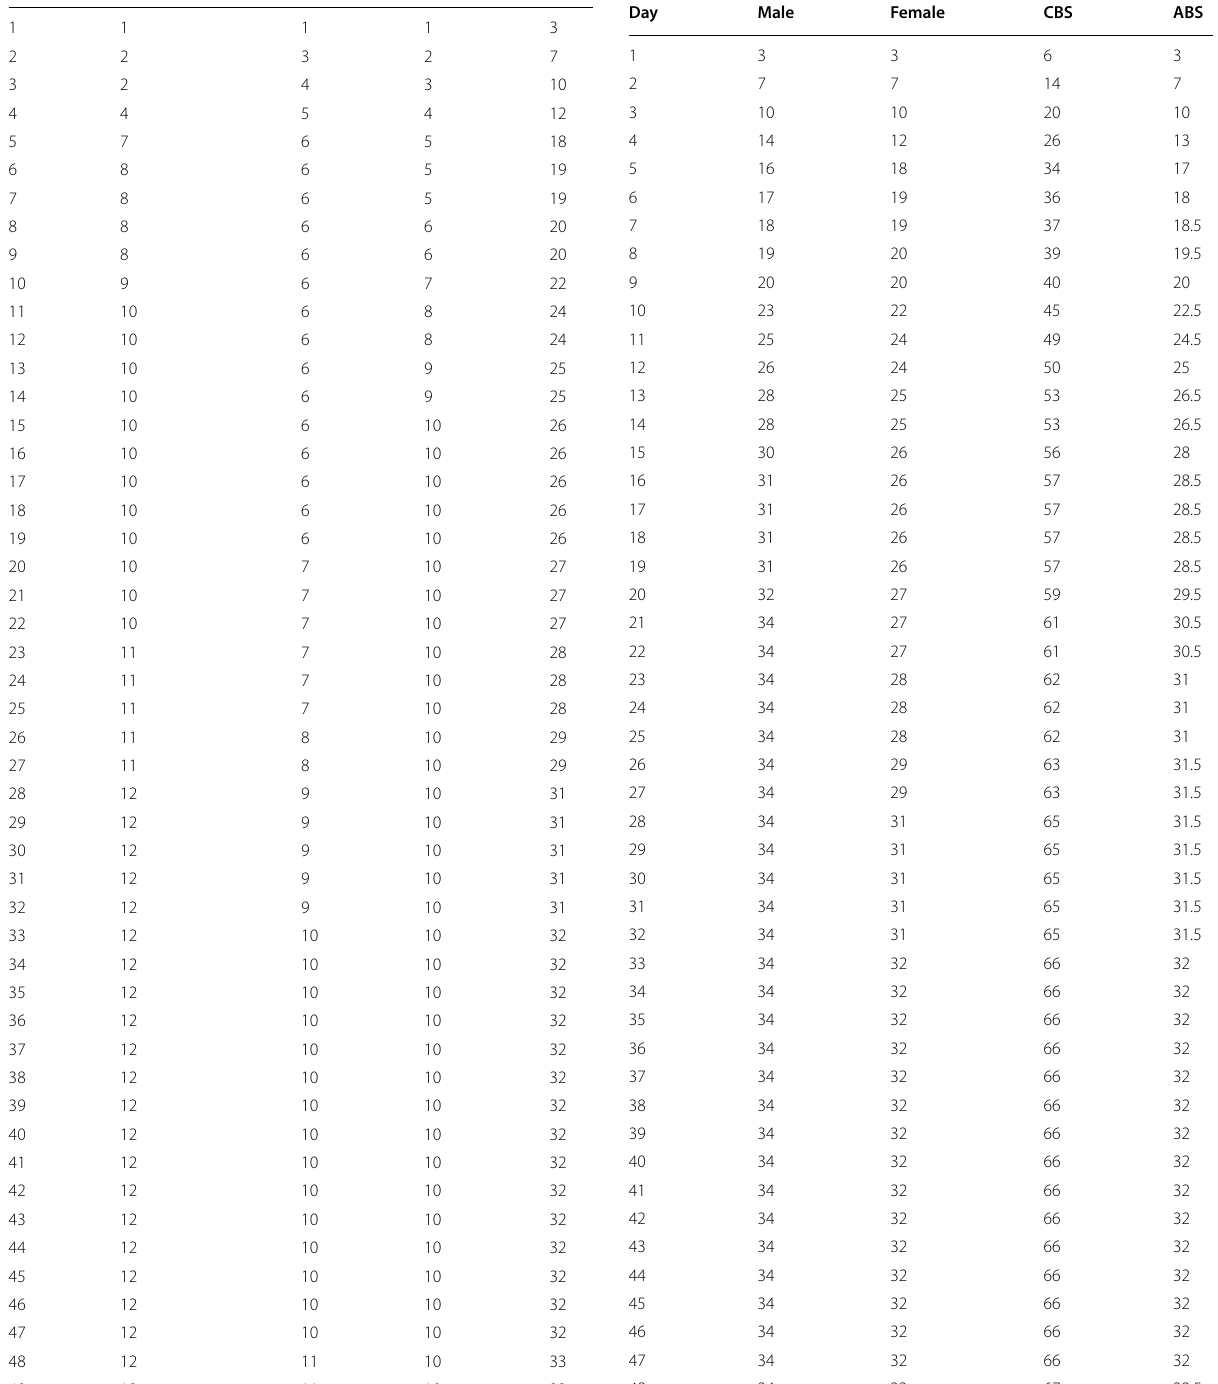
Table 3 Cumulative body scores (CBS) and Average body